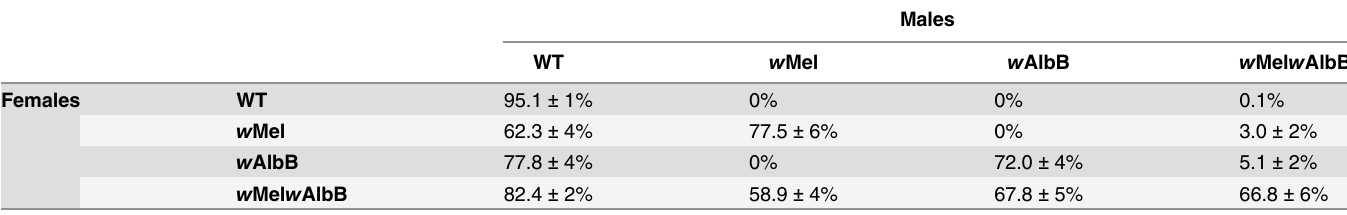
Table 2. Cytoplasmic incompatibility (CI) between Wolbachia infected and wild type mosquitoes.